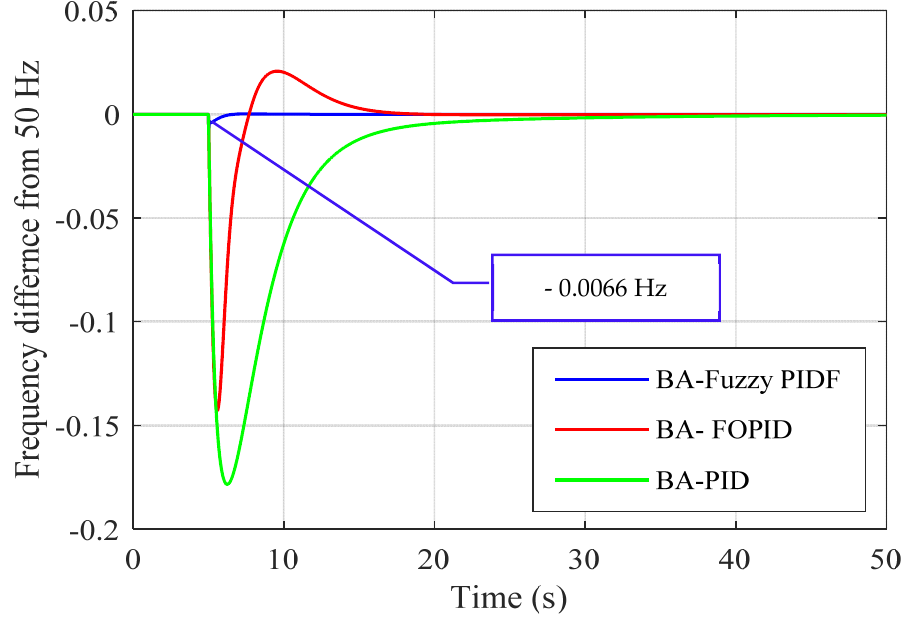
Figure 13. Comparison of three controllers tuned by BA based on ISE for scenario 2.